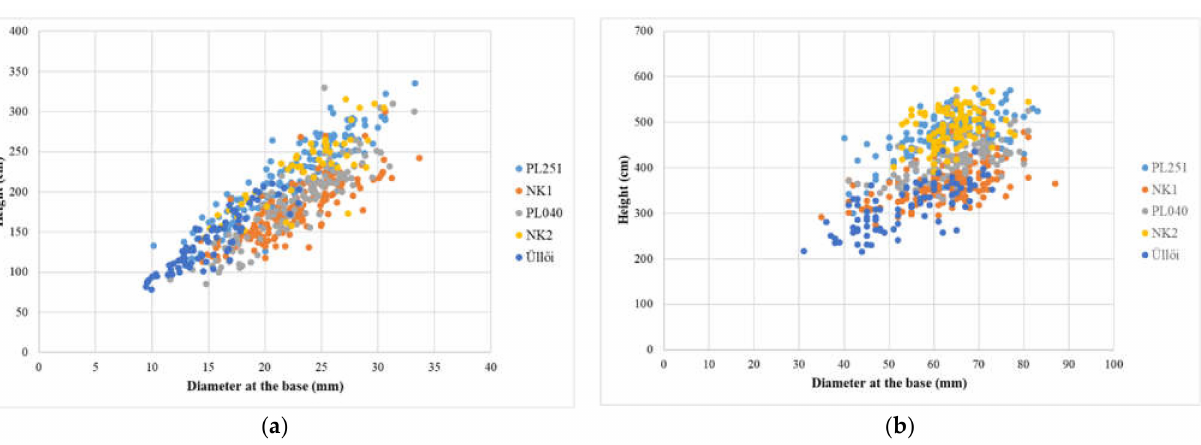
Figure 6. Comparison of results of full inventories: ( a ) May 2021; ( b ) November